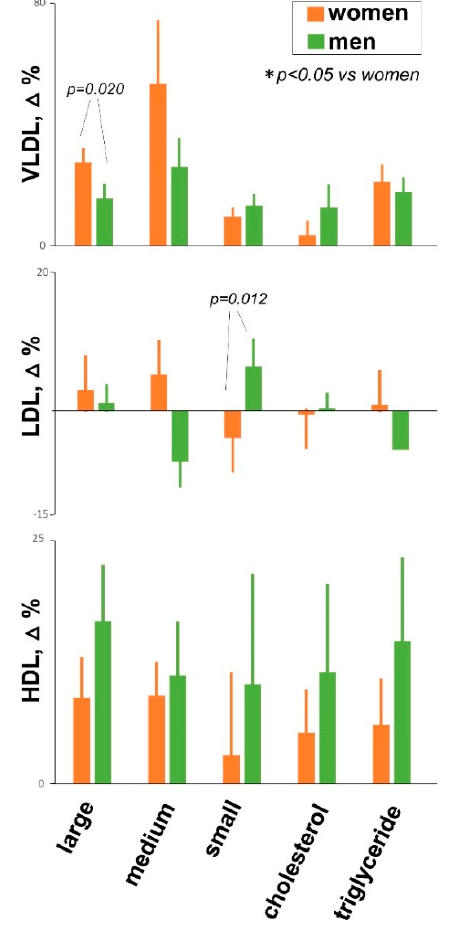
Figure 3. Lipidic response to meal ingestion. Meal ingestion induced changes in the profile of plasma lipoproteins with differences between women and men. Dara are means ±